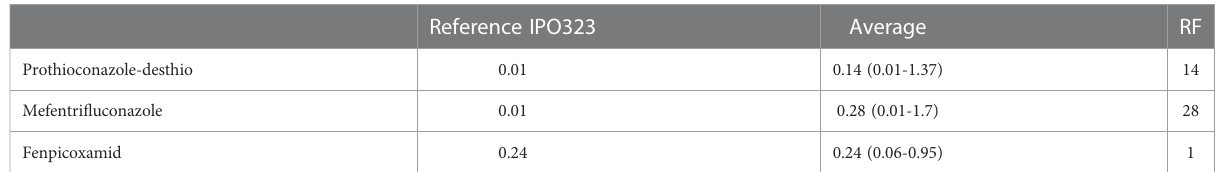
TABLE 2 Mean EC 50 (mg/l) values and resistance factors (RF) for prothioconazole-desthio, mefentri fl uconazole and fenpicoxamid in Z. tritici isolates from Lithuania.